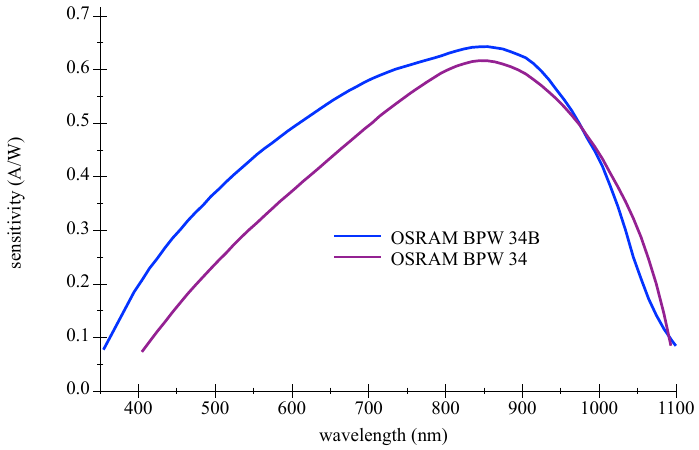
Figure 5. Spectral sensitivity curves for OSRAM BPW 34 and BPW 34B Si PIN Photodetector. Redrawn with values from datasheets [34,35].